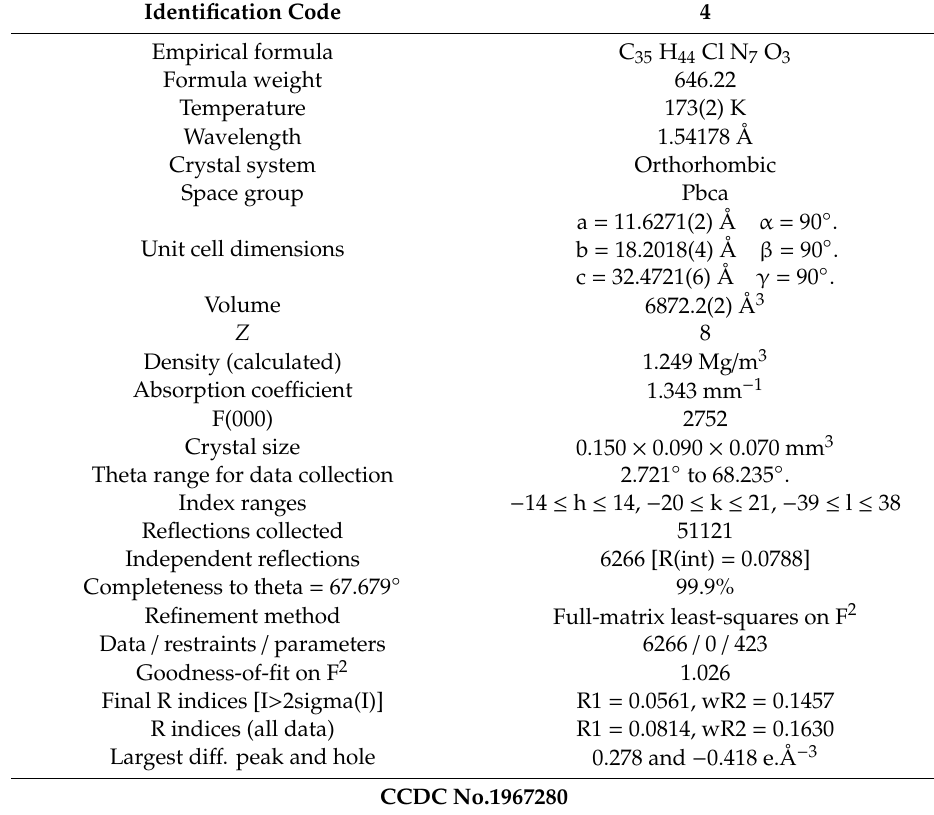
Table 1. Summary of data collection and structure refinements of crystal of 4